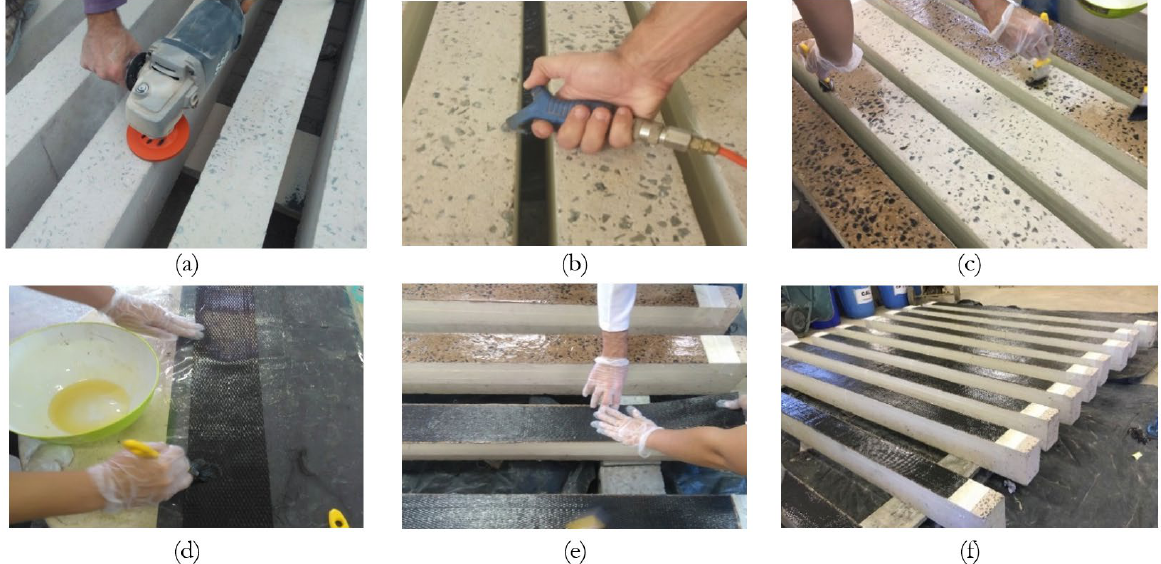
Figure 7. (a) Preparation of the concrete surface, (b) surface cleaning with compressed air, (c) application of the primer, (d) impregnation